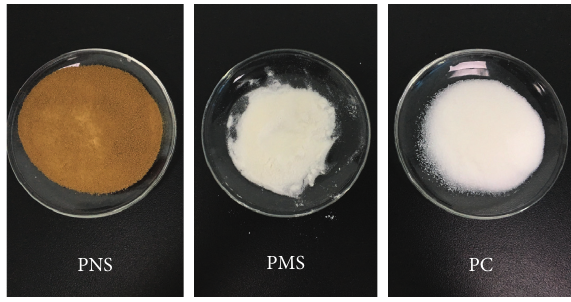
Figure 4: Three types of superplasticizers used in the test. Table 2: Mix proportions of fresh